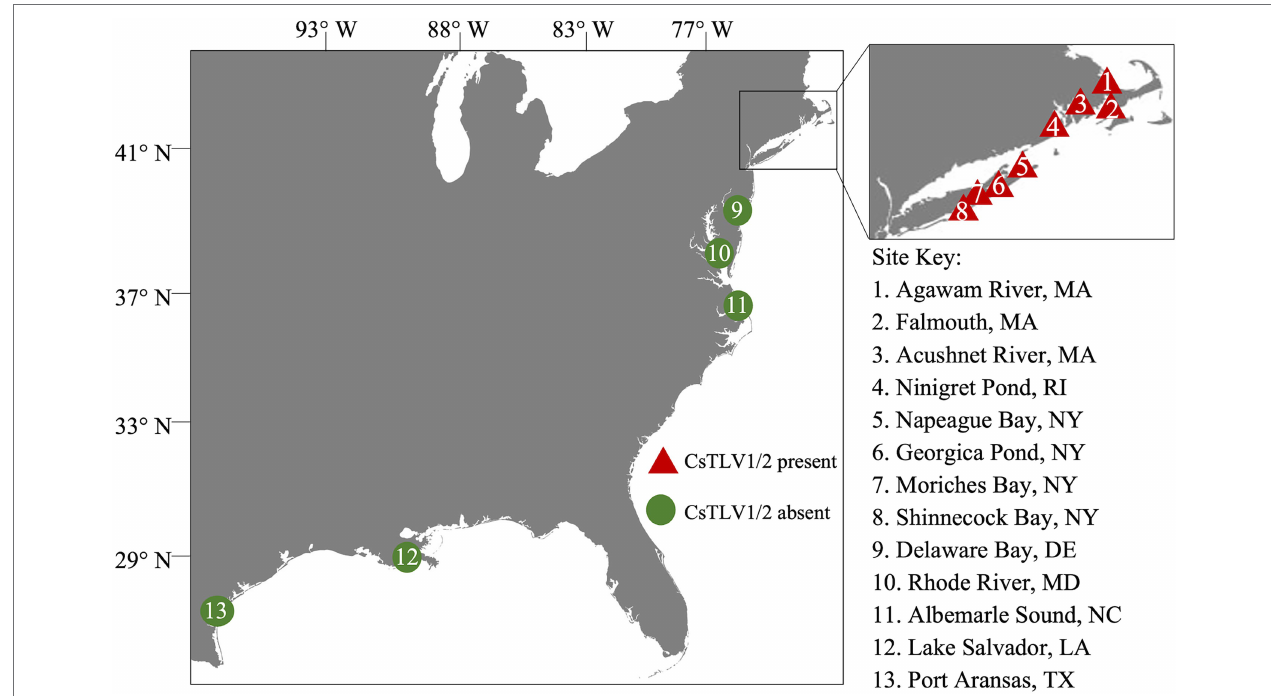
FIGURE 1 | Sampling sites in the northeastern Atlantic coast of the United States. Triangles 1–8 within the inset show sampling sites in MA, RI, and NY. Circles 9–13 indicate sampling sites in DE, MD, NC, LA, and TX. Red color indicates the presence of Callinectes sapidus toti-like virus 1 (CsTLV1) and Callinectes sapidus toti-like virus 2 (CsTLV2); and green indicates the absence of CsTLV1 and